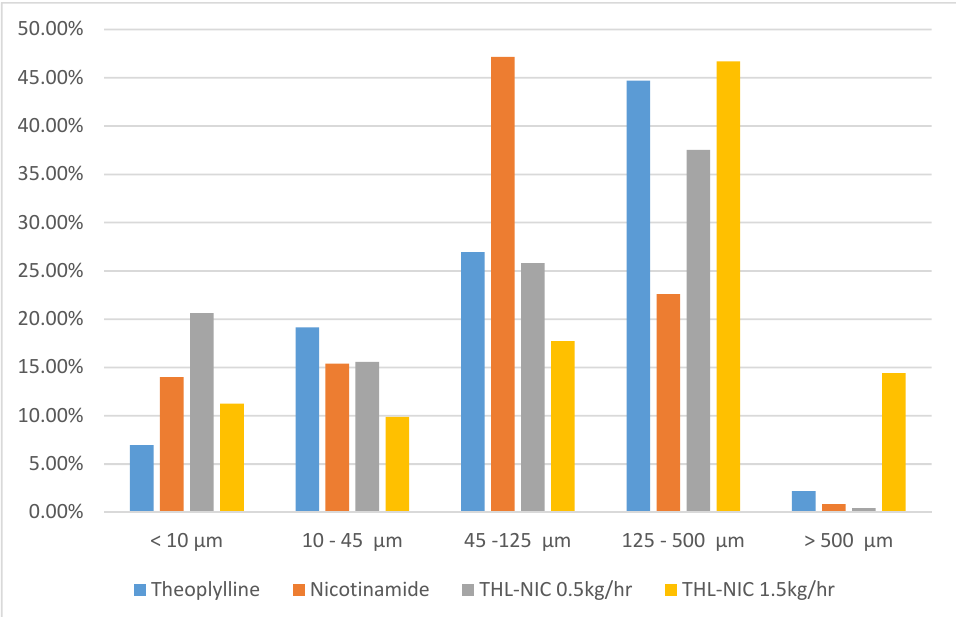
Figure 3. Graph showing the particle size distribution for the bulk products and extruded cocrystals.